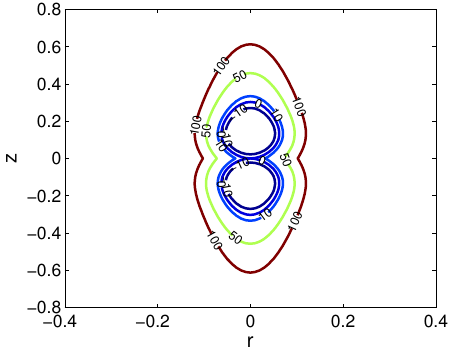
Figure 7. Contours of a vortex in a gaussian stratification with ρ 0 = 1060 kg / m 3 in the mid-plane, for ρ v = 1013 kg / m 3 and di ff erent